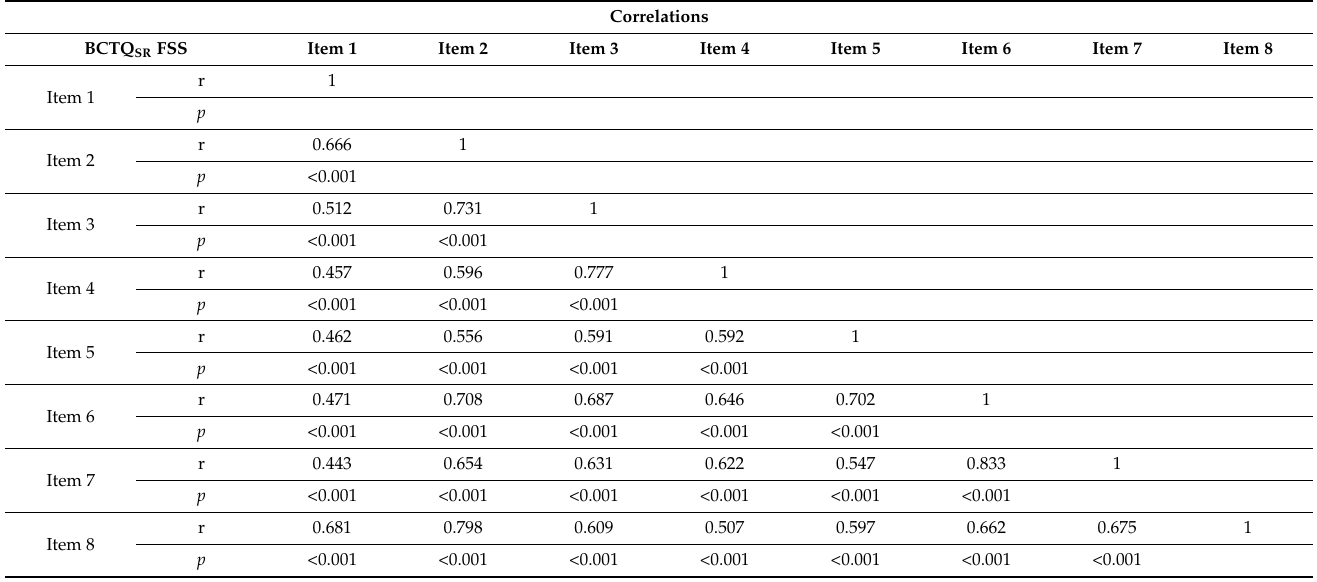
Table 5. Correlations between FSS items on the test.